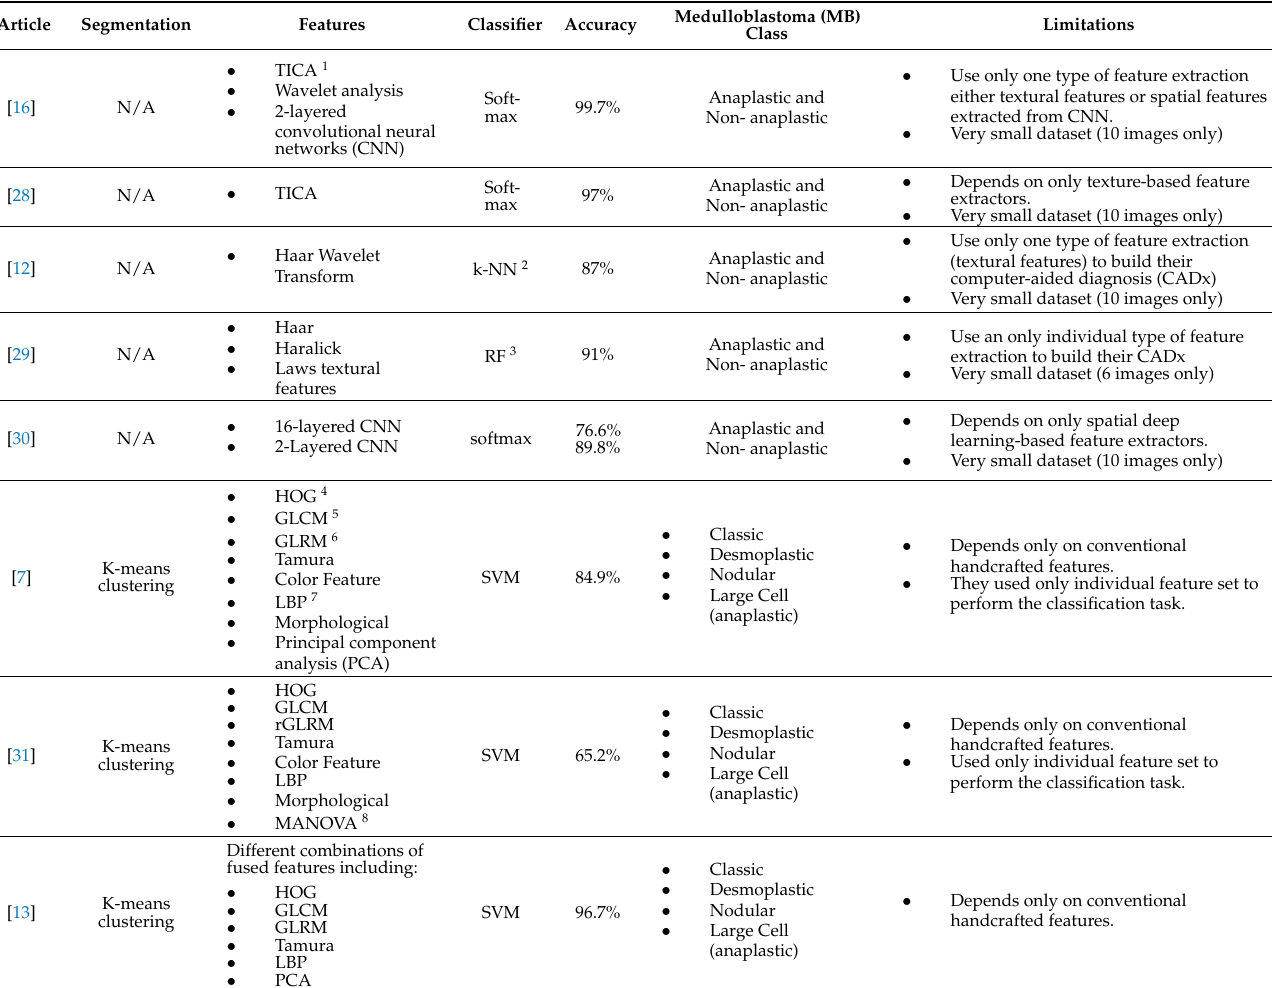
Table 1. A list of related studies that used histopathological images along with their